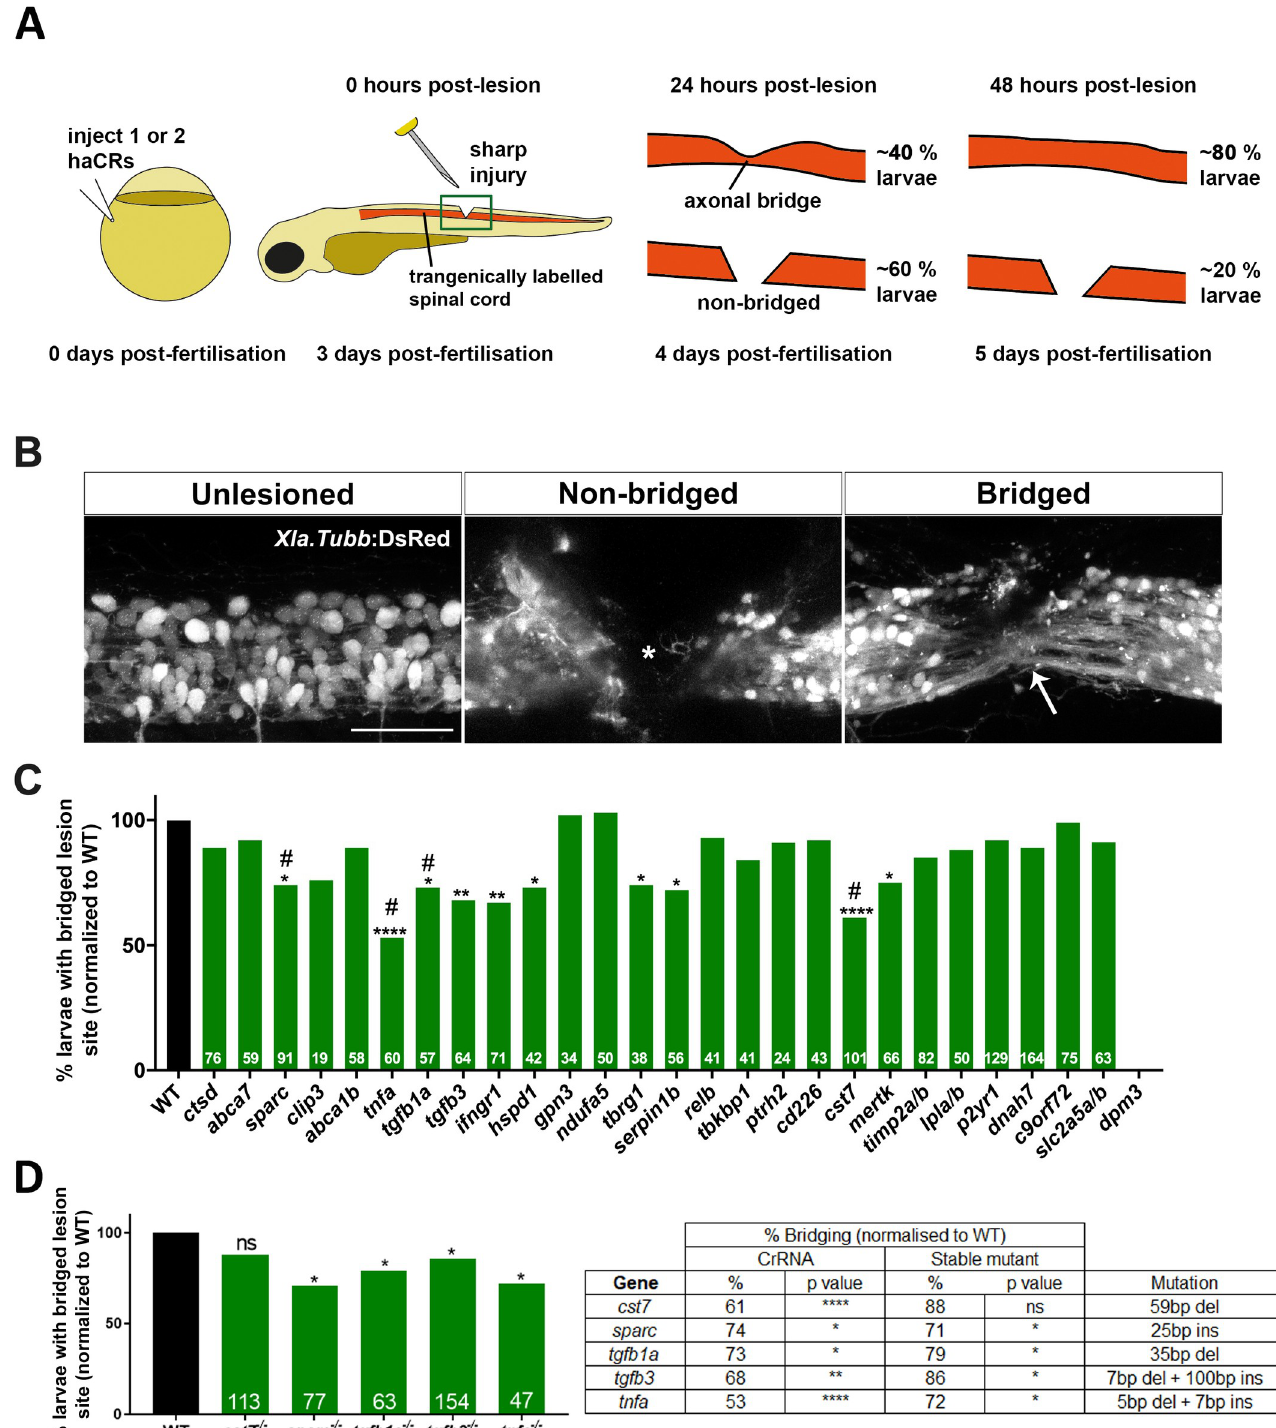
Fig 2. Phenotypic screening reveals modifiers of spinal cord regeneration. A: A schematic representation of the spinal cord regeneration assay. Percentages indicate expected proportions of larvae with an injury site bridged by axons in controls. B: Example images of unlesioned, non-bridged (star indicates gap of neuronal labeling) and bridged spinal cord (white arrow) are shown (lateral views). Scale bar = 50 μ m. C: Results of spinal cord regeneration screen for all screened genes at 48 hpl are shown. Significant reductions in bridging, normalised to control lesioned animals, are observed for cst7 (p < 0.0001), sparc (p = 0.04), tgfb1a (p = 0.03), tgfb3 (p = 0.005), tnfa (p < 0.0001), ifngr1 (p = 0.0013,) hspd1 (p = 0.011), tbrg1 (p = 0.0494, serpinb1 (p = 0.0279), and mertk